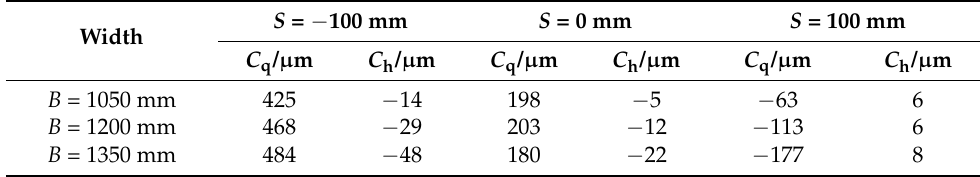
Table 5. Results of the influence of roll shifting on strip